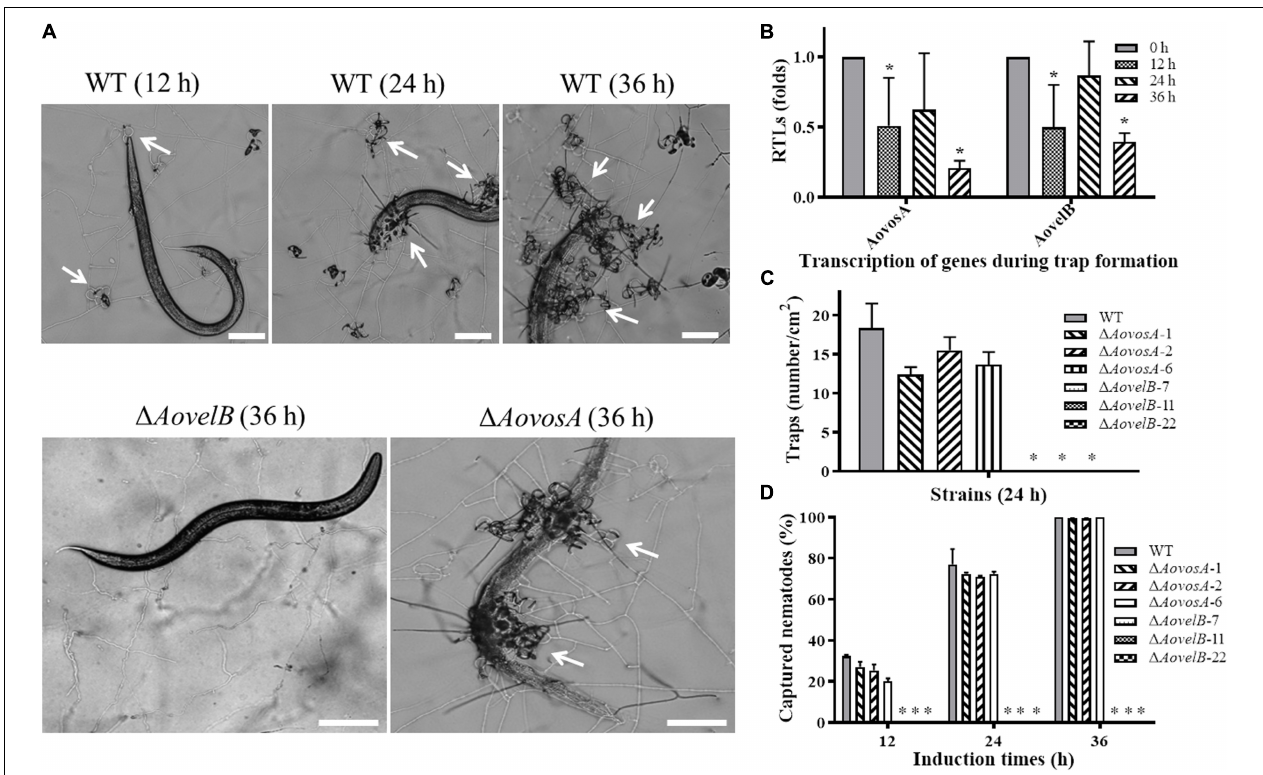
FIGURE 8 | Comparison of trap formation and nematicidal activity in the WT and mutant lines. (A) Trap formation in the WT and mutant lines induced by nematodes at different time points. The arrows show the traps produced by the WT strain and (cid:49) AovosA mutants. Bar: 100 µ m. (B) The relative transcriptional levels (RTLs) of genes AovosA and AovelB in A. oligospora during different induction times by nematodes. (C) Nematode-induced trap numbers produced by the WT and mutant lines at 24 h. (D) The percentage values for the nematodes captured by the WT and mutant lines at different time points. An asterisk indicates a significant difference between the mutants and the WT strain ( p <